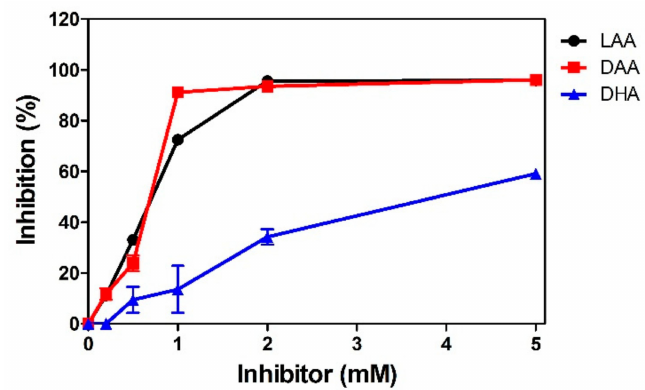
Figure 4. Inhibition of RD-quinone formation by L-ascorbic acid (LAA), D-ascorbic acid (DAA), and dehydroascorbic acid (DHA) at 37 ◦ C.